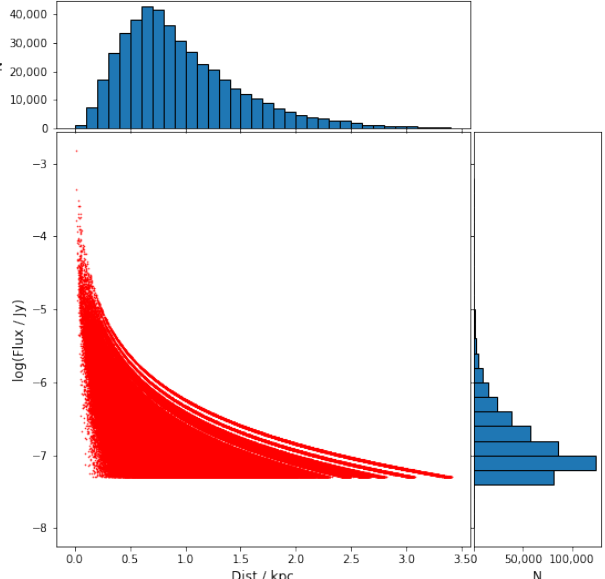
Figure 8. The distribution of distance and estimated fluxes of detectable M dwarf flares. The upper panel is for the distance, while the right is for the flux. The middle panel shows how the flux varies with distance. The striping is due to the binning used on the flare fluxes. The flare flux refers to the average flux over the 20-min